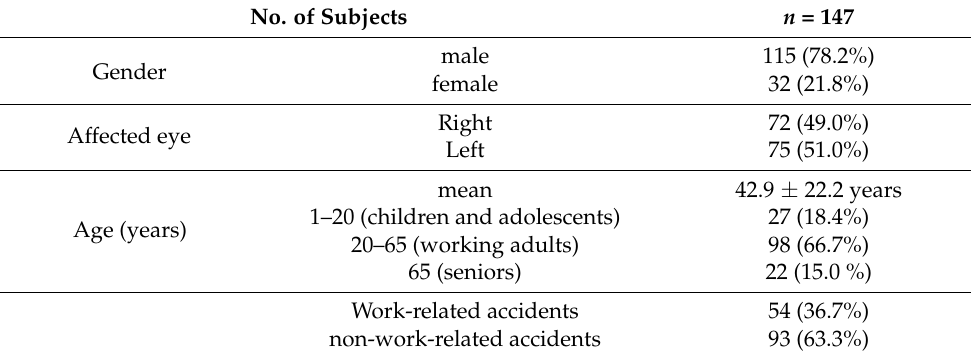
Table 2. Patients’ characteristics, age groups and percentage of work-related